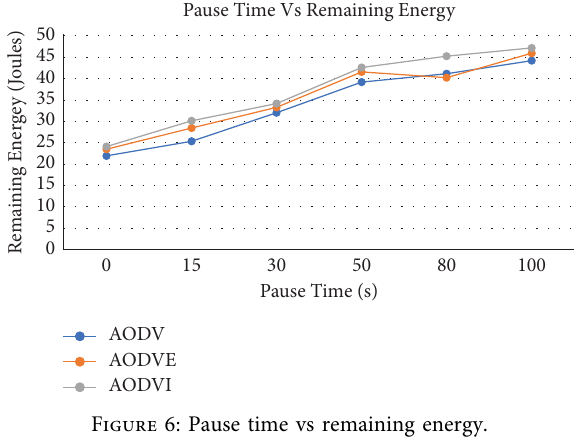
Figure 6: Pause time vs remaining energy.